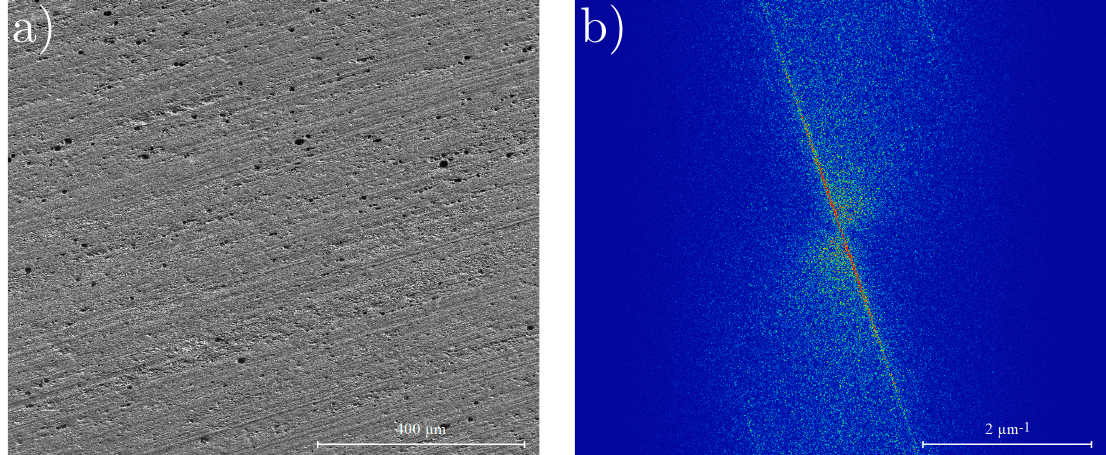
Figure A3. ( a ) An additional SEM image of the Ref sample and ( b ) the corresponding 2D-DFT. For determining the distance between the grooves the normalized spectrum along the pronounced line is shown in Figure A4. The most dominant frequency belongs to a groove distance of 3.3 µm. Considering the peak-to-valley distance of D h = 1.60 µm (see Table 3) the neglecting of shadowing effects is reasonable for our samples.